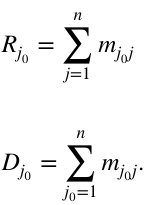
+ D j 0 and the causal 0